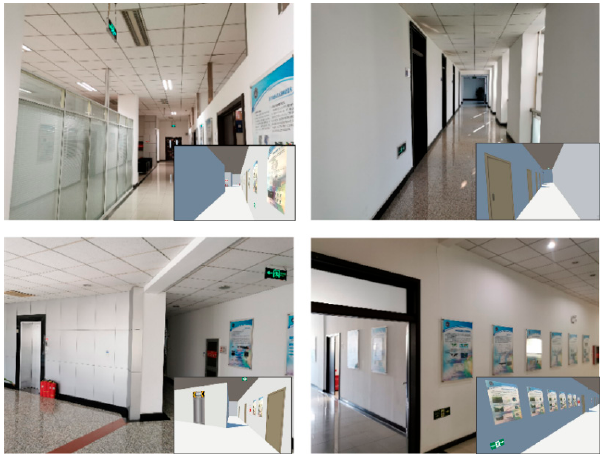
Figure 2. Real and virtual research area with an evacuation guidance system.